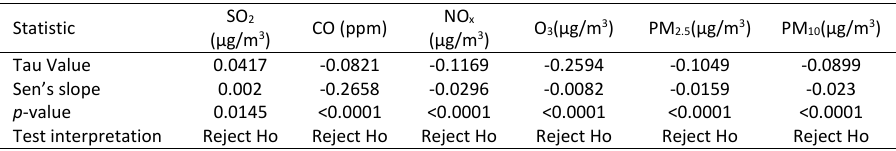
Table 2: MK trend test with 5% level of significance Table 2. MK trend test with 5% level of significance